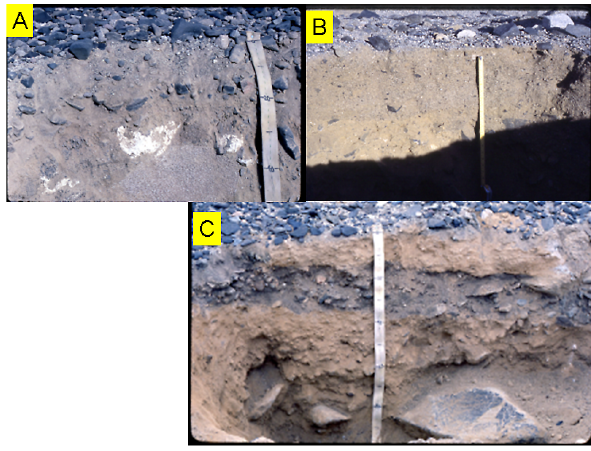
Fig. 3. Further examples of burial soils in the Transantarctic Moun- tains: (A) a mega-ripple of unknown age that has developed down to the salt pan of a soil developed on Alpine IIIb drift on the west side of the Conrow Glacier, central Wright Valley (pedon 83–41); (B) the upper strandline at Lake Vanda in upper Wright Valley show- ing lacustrine material burying a strongly developed soil of pos- sible Pliocene age (pedon 77–28); (C) a soil derived from Alpine IIIa drift in Wright Valley that buries an intensely developed soil of Alpine IIIb or Alpine IV age (pedon 83–38).